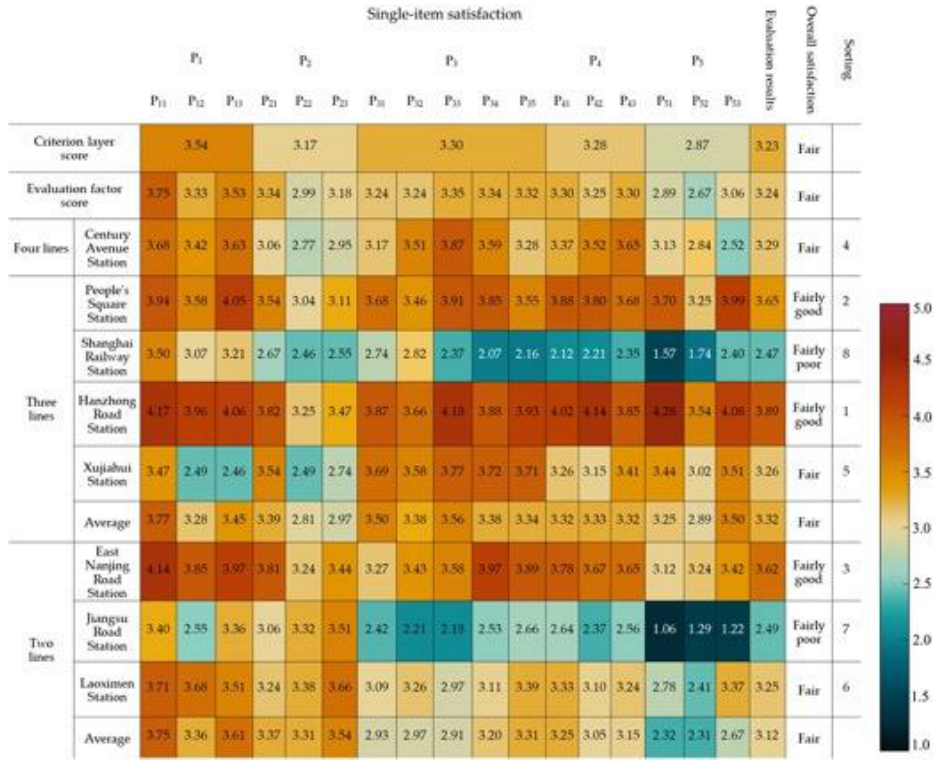
Figure 5. Overall and single-item evaluation scores on the factor satisfaction of transfer space envi- ronments.